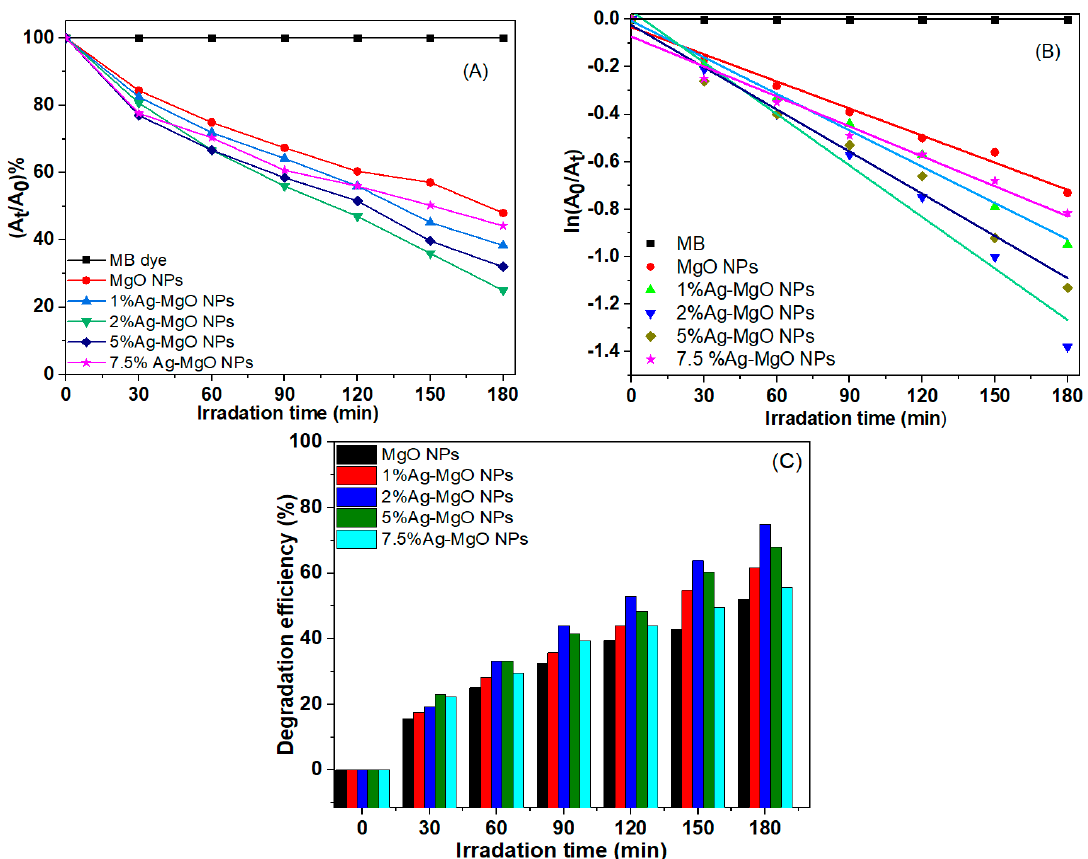
Figure 10. The plot of A t /A 0 versus time for the degradation of MB using pure MgO NPs and Ag ‐ doped MgO NPs under UV irradiation ( A ), kinetic fit for the degradation of MB ( B ), and the efficiency of the degradation (D%) with a period time in range 30–180 min ( C ). Table 2. Comparison of degradation efficiency for various samples on MB dye.